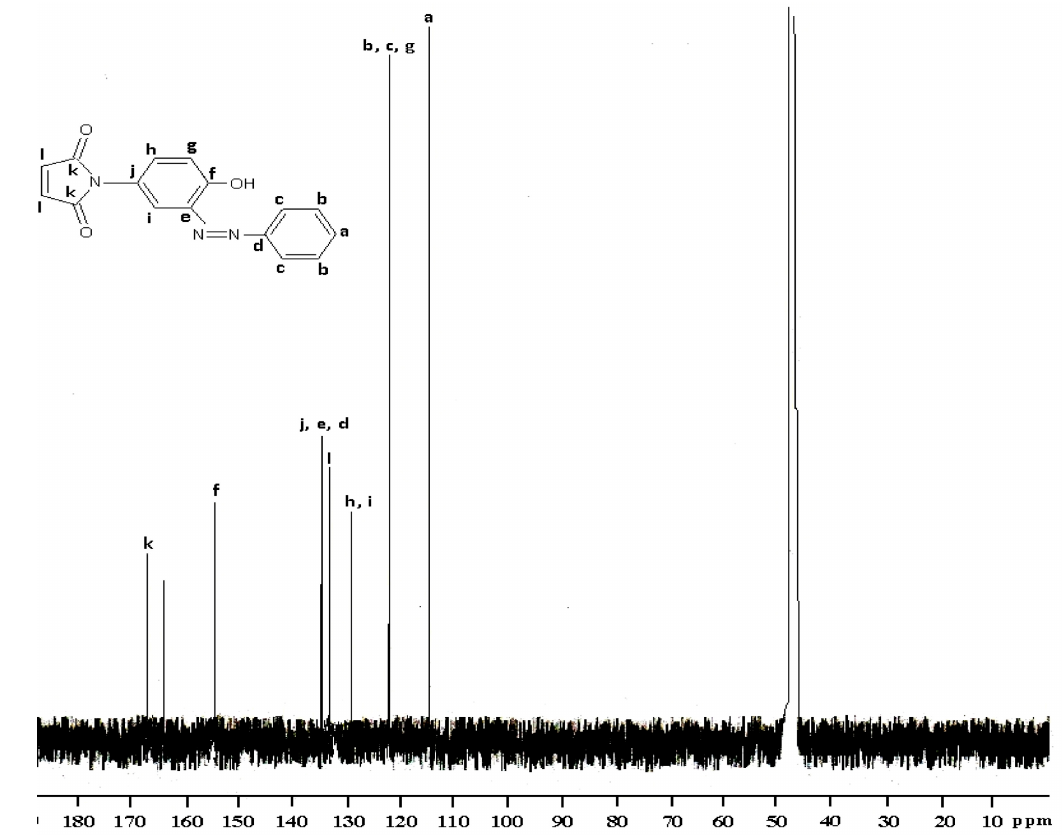
Figure 9. 13 C-NMR spectrum for ( 1 ) (in CD 3 OD) as reported by Mohammed and Mustapha [1].